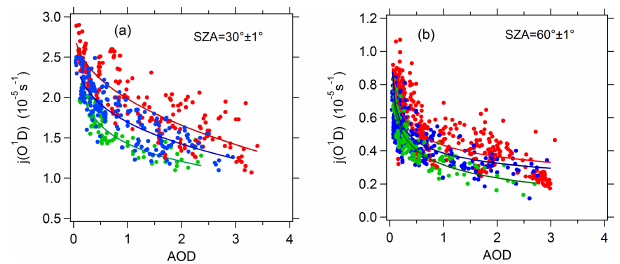
Figure 4. Dependence of j (O 1 D) on AOD (380nm) at SZAs of (a) 30 ◦ and (b) 60 ◦ and at different classes of ozone column concen- tration: 300–330DU (red), 330–360DU (blue), and 360–390DU (green). The full lines are fitted by the exponential function.